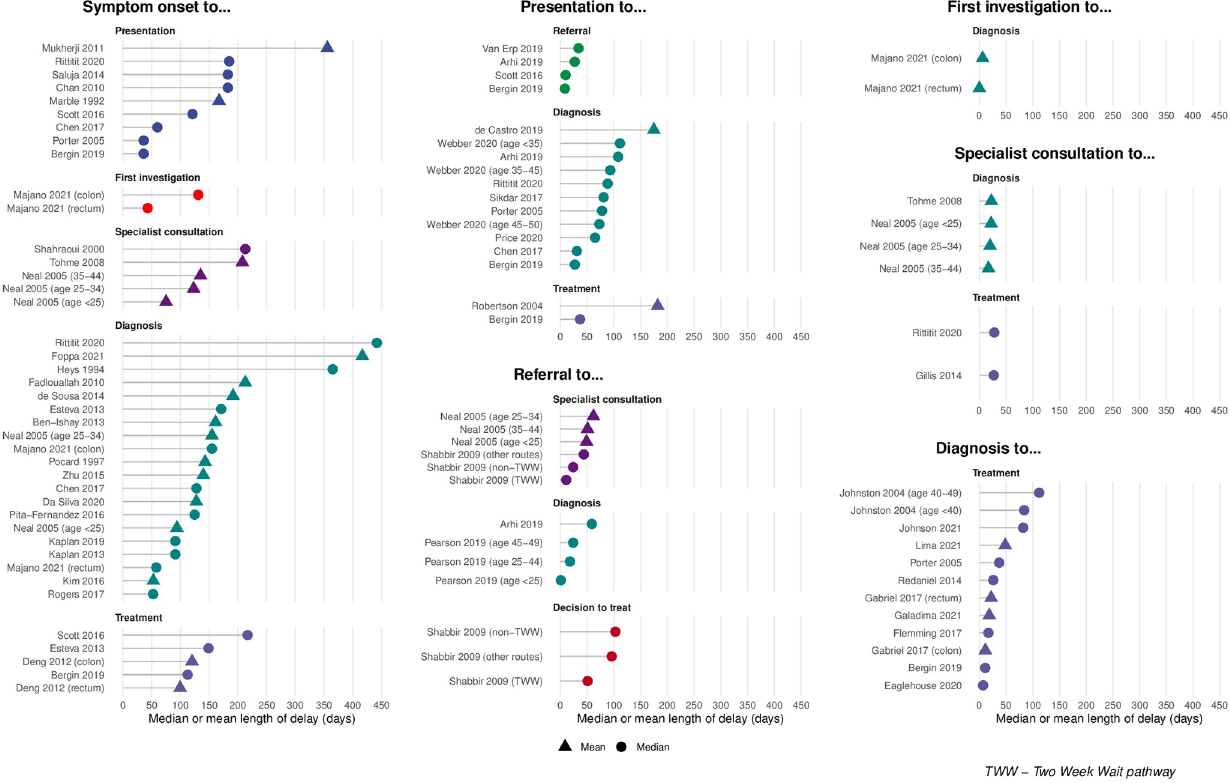
Fig 4. Lengths of unique intervals reported by studies of younger adults with colorectal cancer. Bars represent a single measure from one study, and are color-coded to represent the end of the interval. Circles indicate the median, and triangles the mean. When both were reported by a study, the median was given